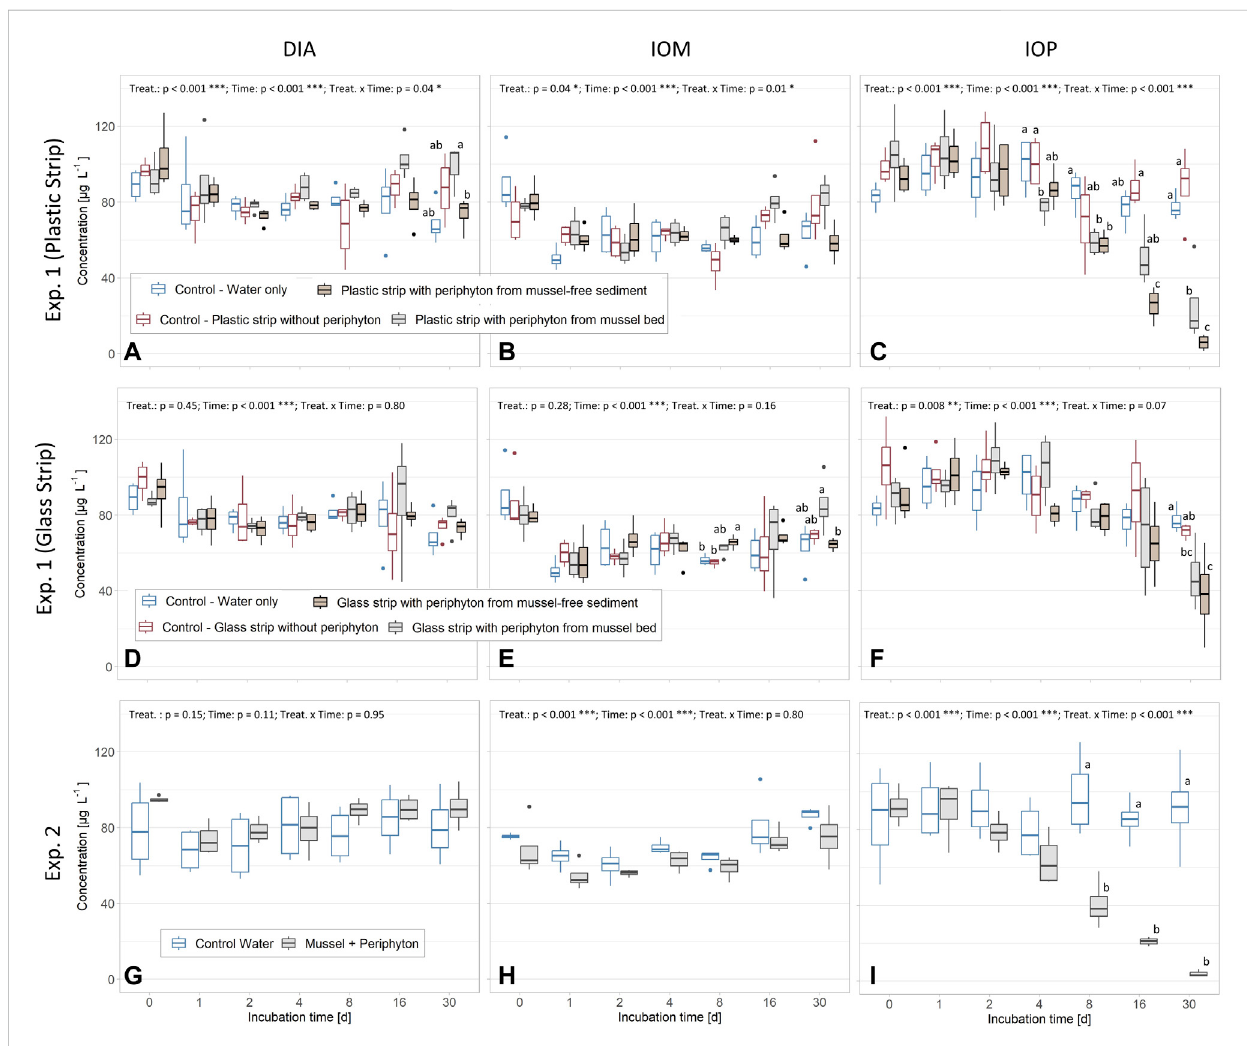
FIGURE 2 Concentrations of diatrizoate (DIA) (A,D and G) , iopamidol (IOM) (B,E and H) and iopromide (IOP) (C,F and I) in water of batch experiment (Exp.) 1 (periphyton grown on plastic and glass strips at mussel bed and mussel-free sediment sites) and batch Exp. 2 (mussels with periphyton). Note the non- linear x -axis distribution which is jointly shown for Exp. 1 and 2. Small letters above boxes indicate signi fi cant differences for each timepoint at p < 0.05 (Exp. 1: Kruskal-Wallis-Test with Wilcoxon Post-Hoc Test; Exp. 2: Mann-Whitney-U). Resultsfor theAligned RankTransformare shown (top of each subpanel) and signi fi cant differences for treatment (treat.), time and their interaction are indicated (*: p < 0.05; **: p < 0.01; ***: p < 0.001). In all experiments, we used four replicates for each of the controls and